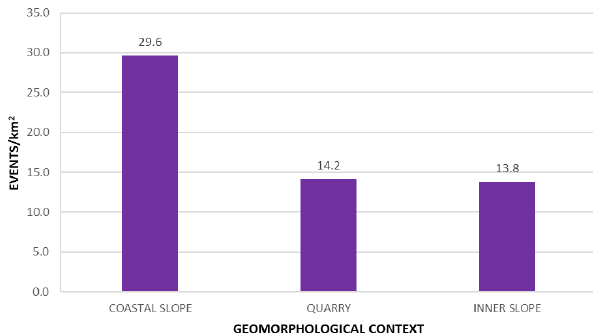
Figure 12. Distribution of the landslide events according to the ge- omorphological